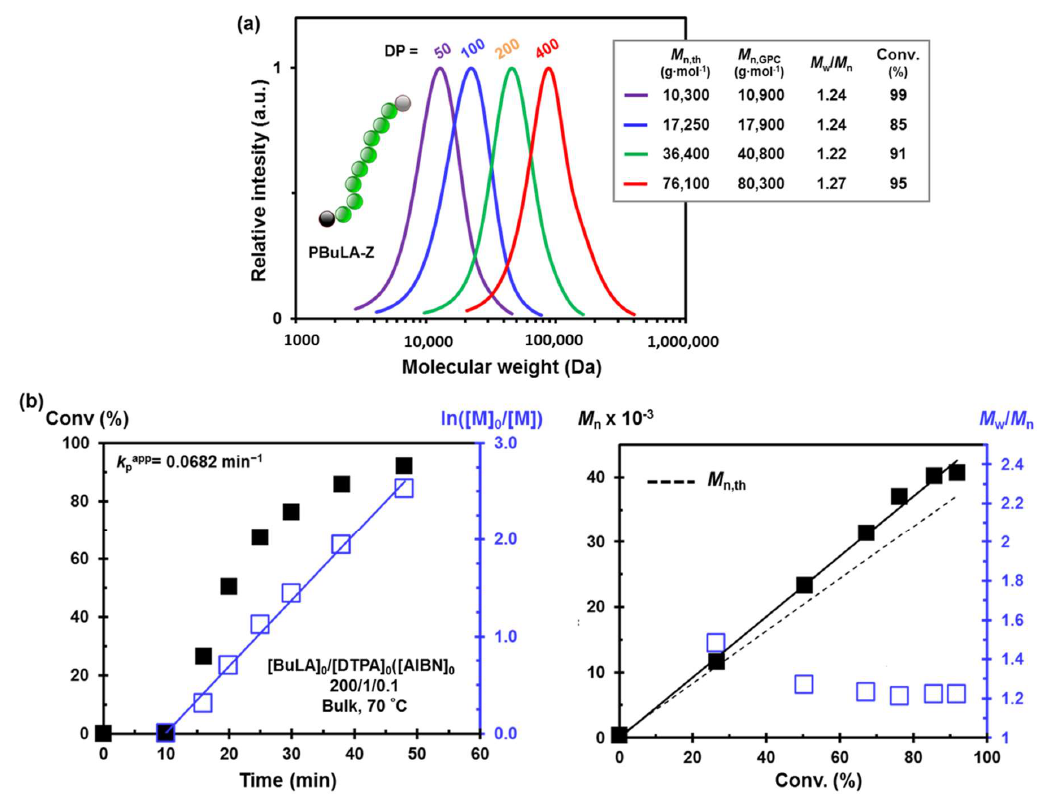
Figure 3. Bulk RAFT polymerization of BuLA with DTPA at 70 ◦ C. ( a ) GPC traces of PBuLA-Z